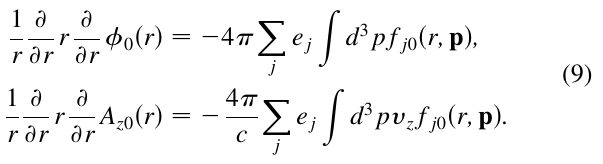
vary from 5% to 25% , where ^ nn